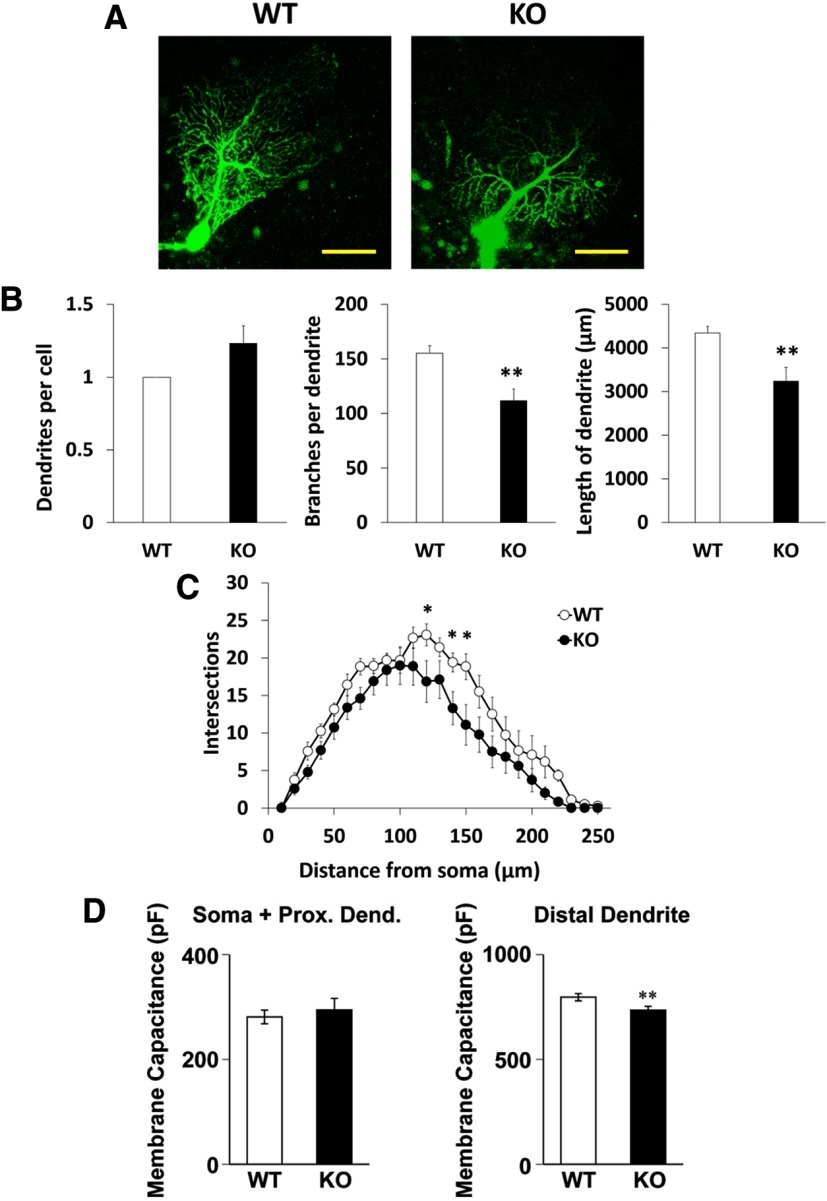
Morphology of Purkinje cells in the cerebellum of DGKγ KO mice. A, Images of Purkinje cells in cerebellar slices from WT and DGKγ KO mice. Purkinje cells were filled with fluorescent dye from the patch pipette. Scale bar: 50 μm. B, A comparison of the number of dendrites and branches and the total length of Purkinje cells from WT and DGKγ KO mice (WT: n = 12; KO: n = 13); *p < 0.05, **p < 0.01, followed by Student’s t test. C, Sholl analysis of the number of intersections of Purkinje cells from WT and DGKγ KO mice (WT: n = 12; KO: n = 13); *p < 0.05, followed by Student’s t test. D, Membrane capacitance of the somatic and proximal dendritic regions (soma + prox. dend.) and the distal dendritic region (distal dendrite) of cerebellar Purkinje cells (WT: n = 24; KO: n = 21); *p < 0.05, followed by Student’s t test. Data are expressed as mean ± SEM.